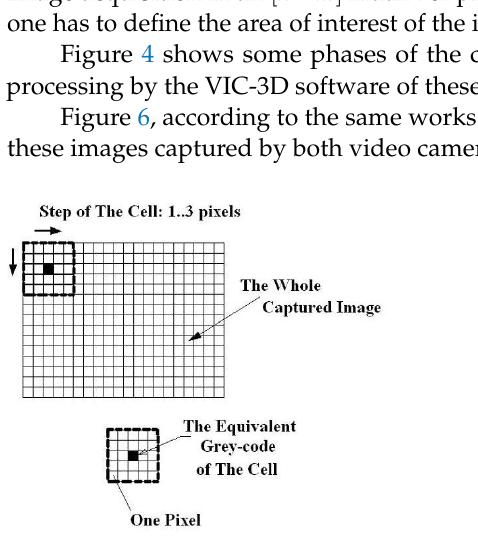
Figure 7. The principle of the stereo image analysis [26,27,29].